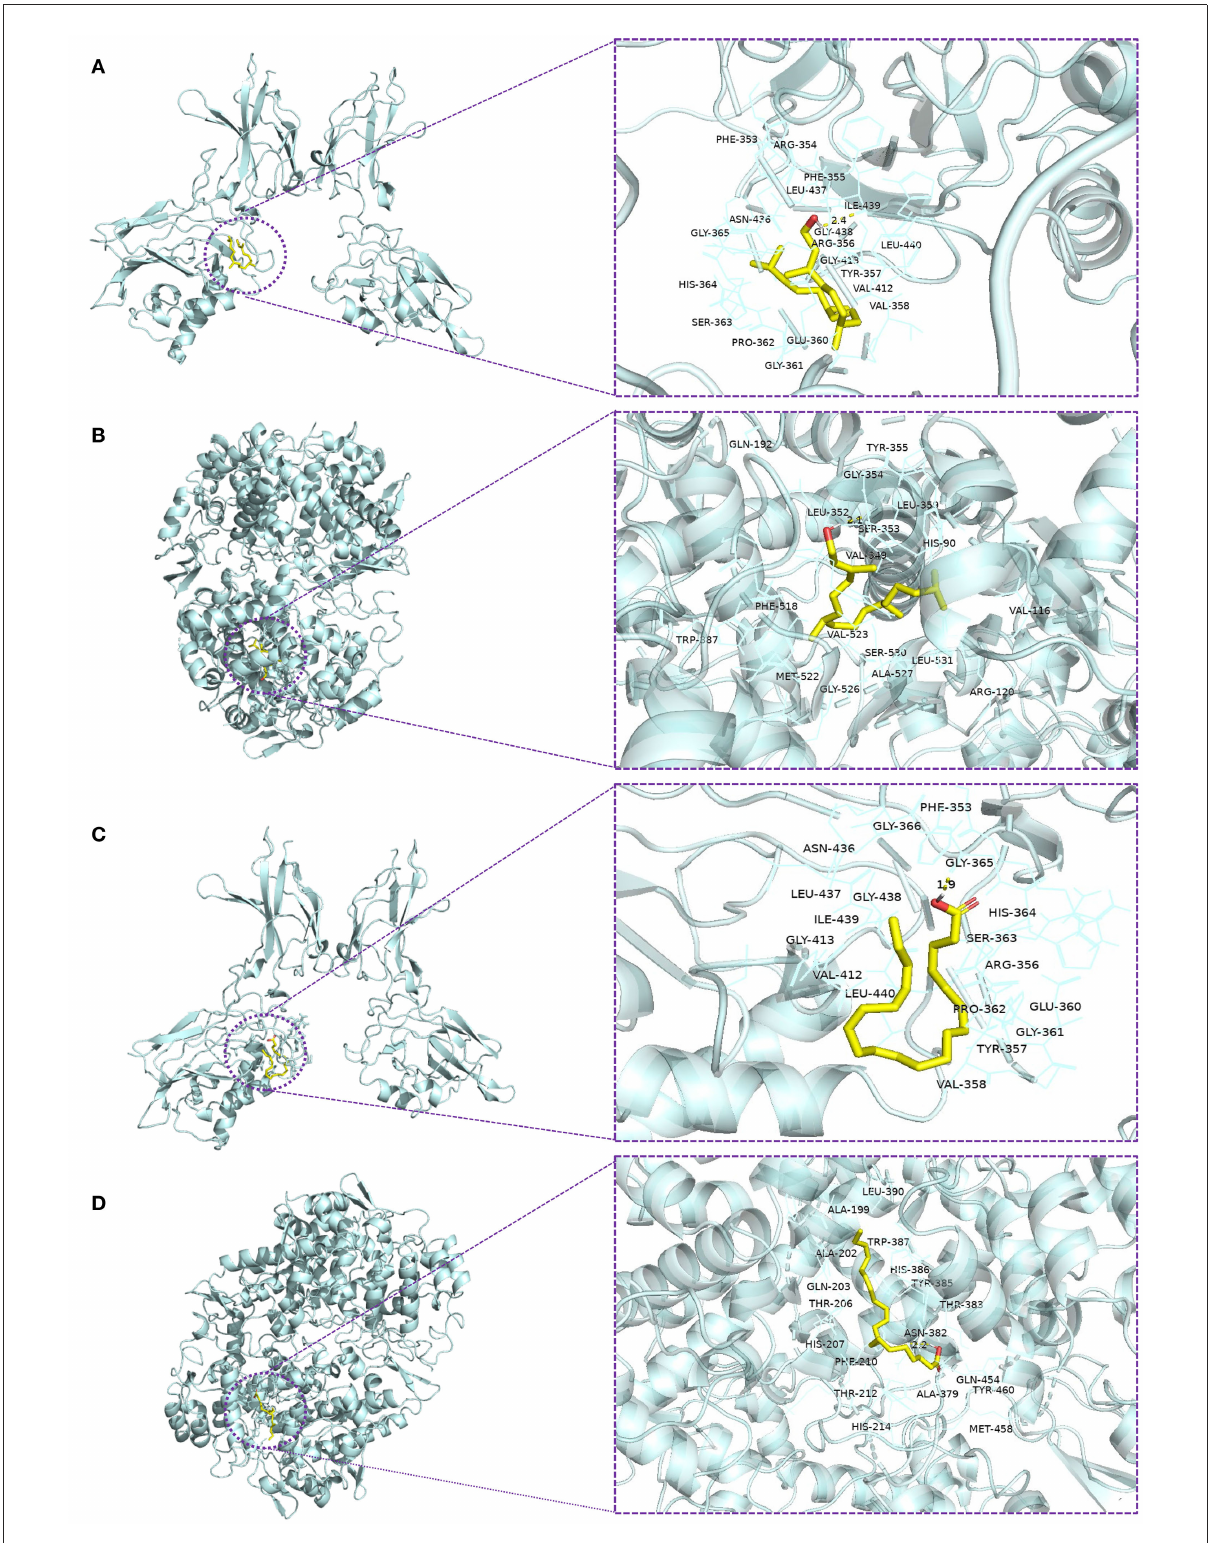
FIGURE4 Molecular docking of ligands with their potential targets. Docking interaction 3D view of phytol with NF- κ B (A) and COX-2 (B) , and eicosatrienoic acid with NF- κ B (C) and COX-2 (D) . Residues are within the distance of 4Å, and the yellow dotted lines indicate hydrogen